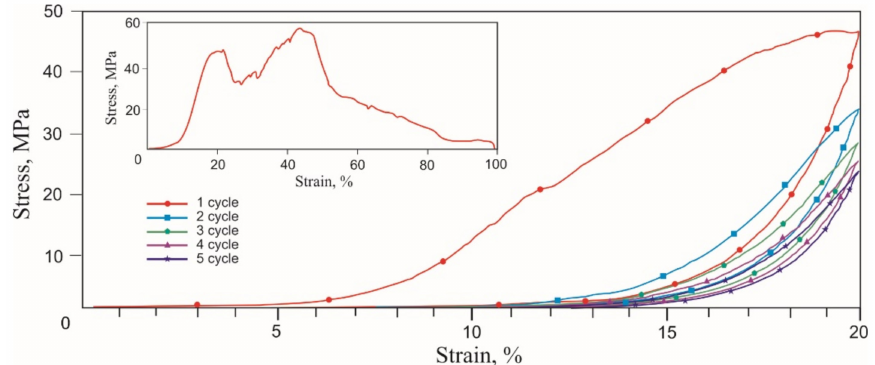
Figure 7. Engineering tensile stress-strain curves of the tendon 5 loading-unloading cycles and uniaxial tension to rupture (inset).